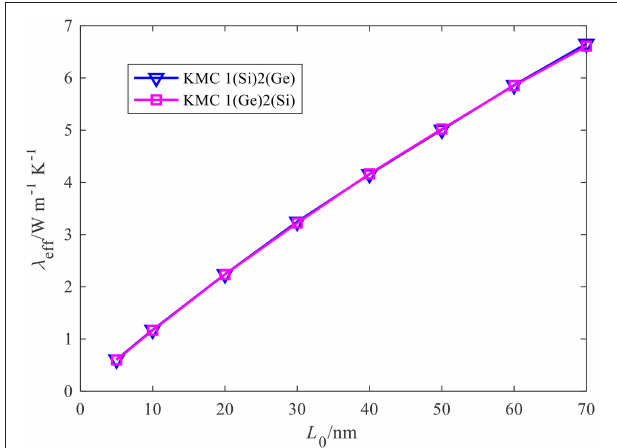
FIGURE 5 | The effective thermal conductivity at different thicknesses for one layer of the multilayer film system. The line with down triangle is for 1(Si) and 2(Ge) collocation whereas the line with square is for 1(Ge) and 2(Si)